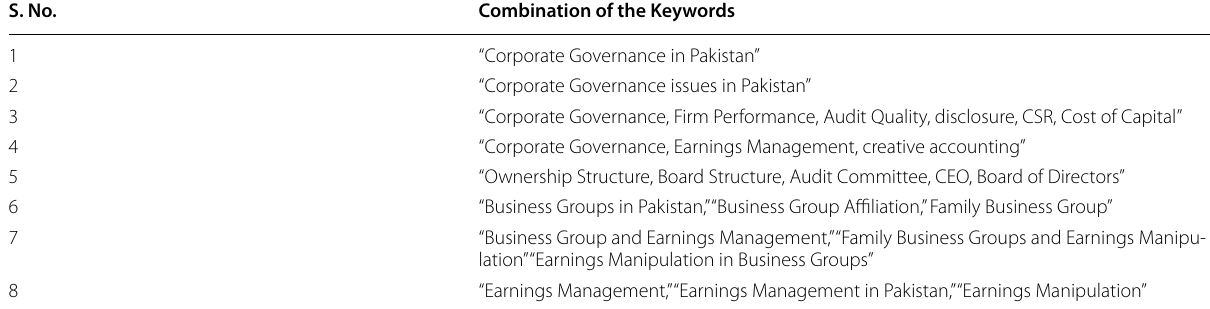
Table 1 Keywords combination used for the systematic literature review S.